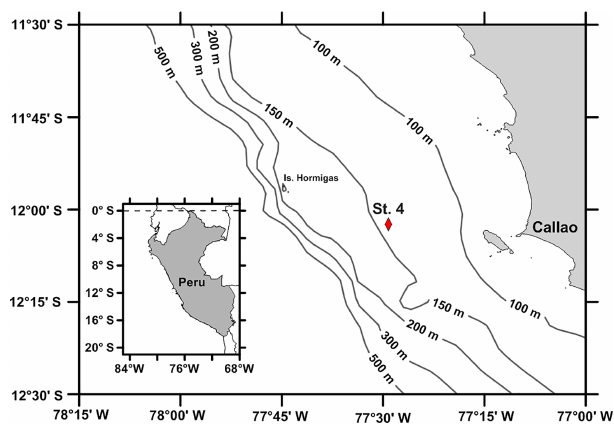
Figure 1. Location of the sampling station (St. 4; 20nm, 145m depth) in the coastal upwelling ecosystem off central Peru, Callao (12 ◦ 02 (cid:48) S, 77 ◦ 29 (cid:48)